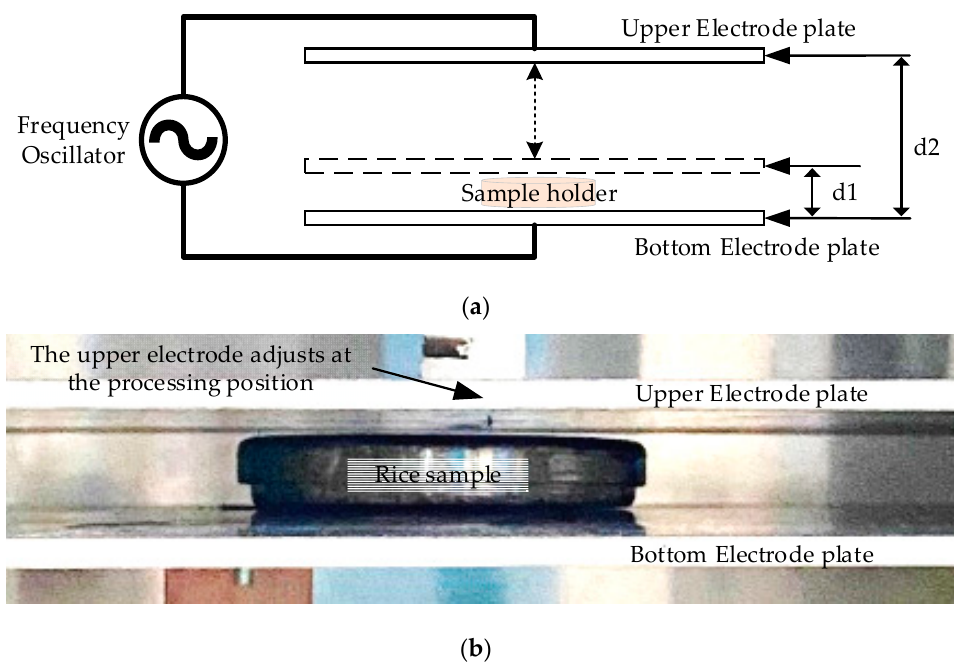
Figure 3. Schematic diagram of dielectric heating system: ( a ) Dielectric heating system; ( b ) Samples in dielectric heating system.